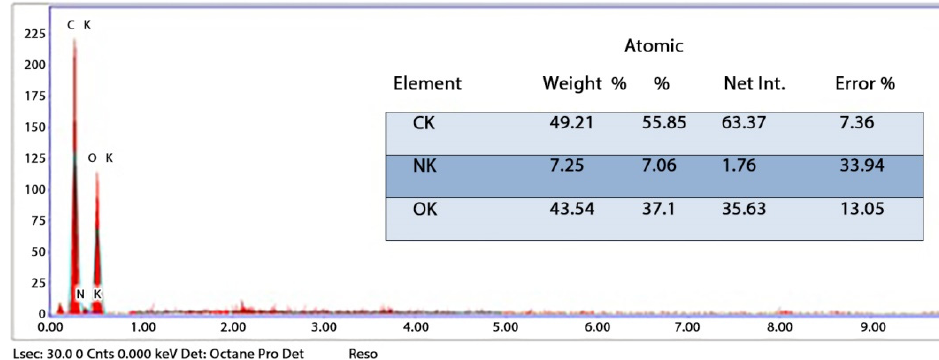
Figure 3. Energy-dispersive X-ray spectroscopy (EDX) analysis of CSNPs powder.